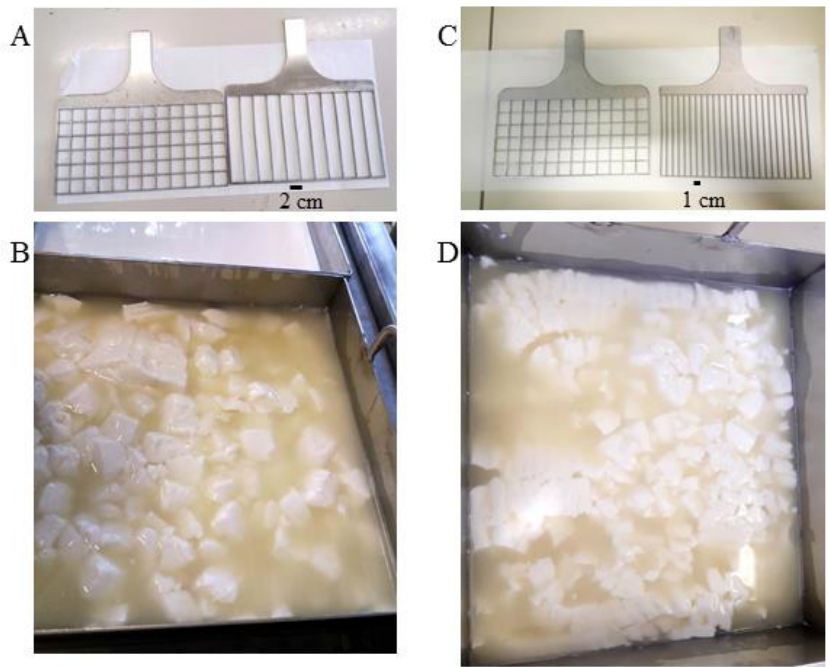
Figure 1. Cutters used for all the lab-cheesemaking productions ( A ) with the relative curd obtained after cutting ( B ) and the modified cutters ( C ) used to reduce the coagulum size after cutting ( D ).